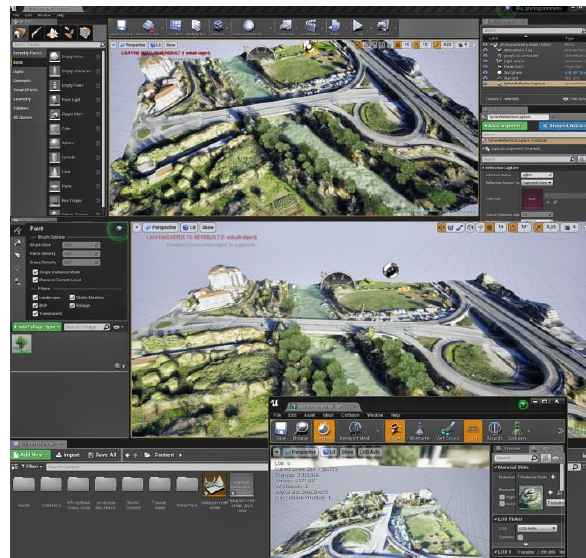
Figure 19: optimized model transfer on Unreal Engine and addition of parametric